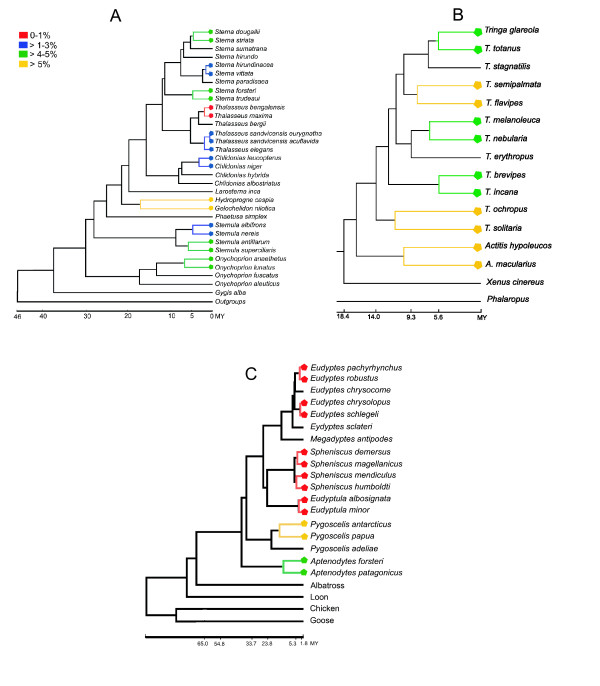
K2P distances of DNA barcodes mapped on chronograms of different lineages of birds. hronograms of diverse clades of birds. Legend correspond to K2P divergence levels in DNA barcodes : a) terns; b) shanks, and c) penguins.